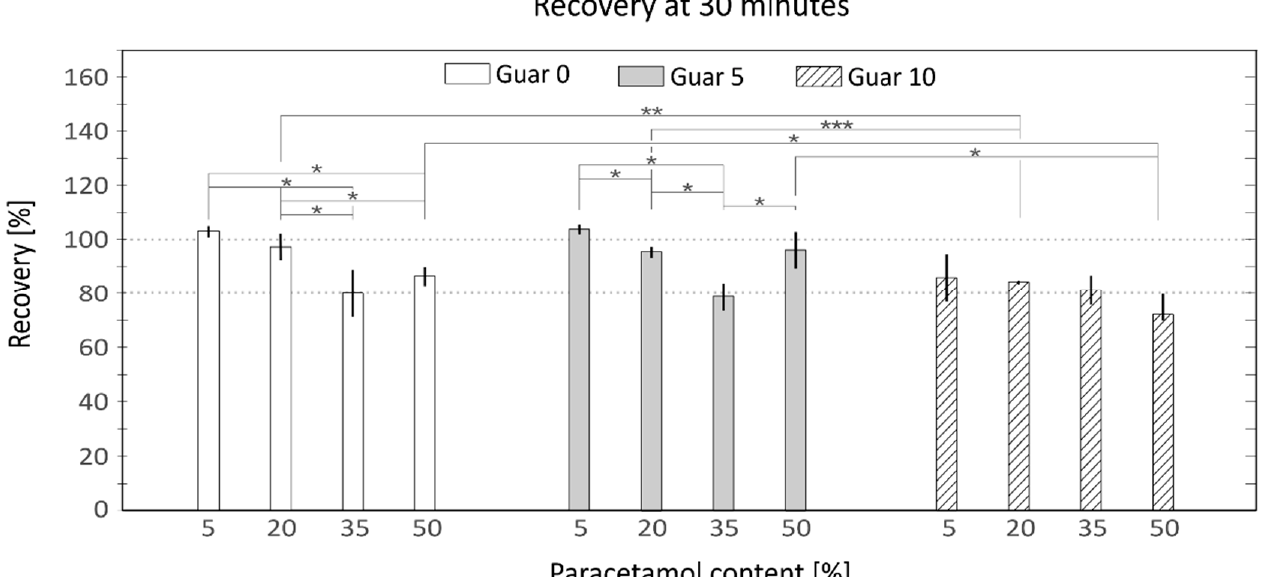
The release of fresh and aged samples was compared at 30 min under agitation at 37 °C. The results are shown in Figure 4 and collected in Supplementary Table S5. Fresh sam- ples yielded higher recovery values compared to aged ones for all API proportions. Fresh samples showed a clear rising trend proportional to the API content, while the aged sam- ples showed the opposite tendency. The observed recovery percentages of fresh samples were (88 ± 3%, 90 ± 1%, 93 ± 2% and 98 ± 3%) and for aged samples were (80 ± 1%, 73 ± 2%, 74 ± 3% and 74 ± 3%) for each paracetamol proportion of 5, 20, 35 and 50%wt. Figure 4. Recovery percentages of samples containing 5% of Guar gum tested in fresh condition (grey stripped) and aged for 6 weeks at room temperature (solid white). Horizontal axis represents the API percentage and vertical axis the % rate of recovery measured with HPLC-DAD (mean ±SD, n = 3, * p < 0.05, ** p < 0.01, *** p < 0.001).